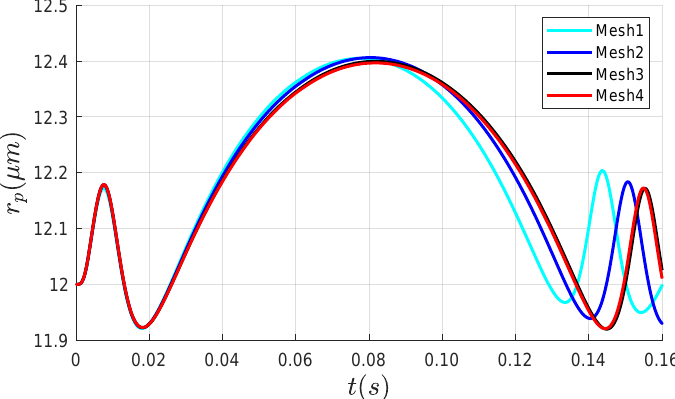
Figure A4. Grid independence analysis for a particle’s radial migration as a function of time for AR = 4, r p 0 = 12 µ m, and a time step ∆ t = 1 × 10 − 5 s. The lines for Mesh 3 and Mesh 4 are very close, which demonstrates that Mesh 3 still has a reasonable accuracy and a more efficient computational